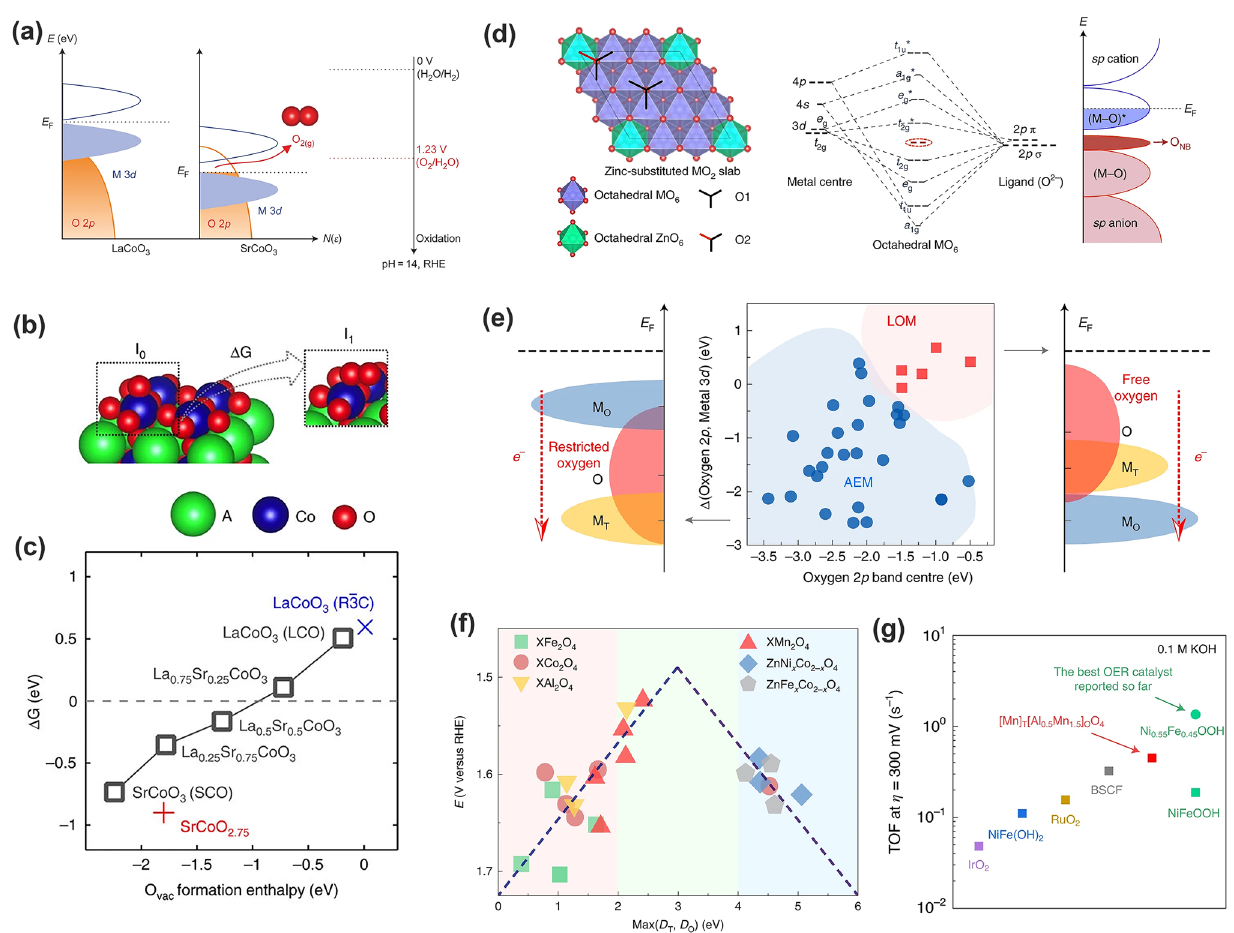
Fig. 11 Lattice oxygen mediated mechanism (LOM) for OER. a Scheme of the band positions to trigger the LOM. The position of the O 2 / H 2 O redox couple at pH 14 is 1.23 V versus RHE [132]. Copyright © 2017 Springer Nature. b Surface configurations of the intermediate after AEM Step 1 (I 0 ) and the one after LOM Step 1 (I 1 ). c The free energy change of I 1 over I 0 versus the O vacancy formation enthalpy for the cubic La 1− x Sr x CoO 3− δ [134]. Copyright © 2016 Springer Nature. d Model of zinc-substituted MO 2 and Schematic formation of ONB by extrapolat- ing the molecular orbital energy diagram for octahedral MO 6 [139]. Copyright © 2019 Springer Nature. e An illustration of how the oxygen 2 p band center, and the relative band centers between oxygen 2 p and active metal 3 d , co-regulate the reaction mechanism of OER on spinel oxides. f The experimentally observed reaction activity as a function of the calculated Max( D T , D O ). g The intrinsic activity of the as-synthesized Al 0.5 Mn 2.5 O 4 and other reference OER catalysts in 0.1 M KOH at an overpotential of 300 mV [131]. Copyright © 2020 Springer